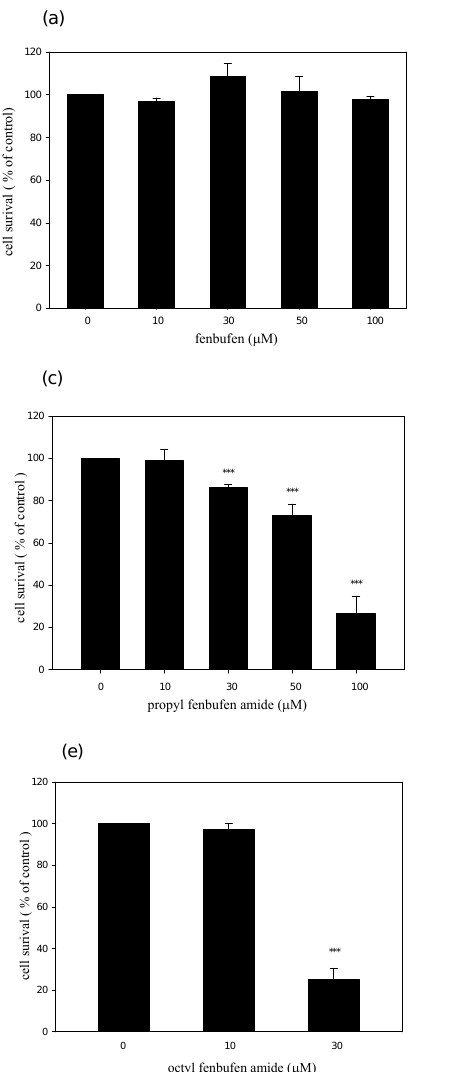
Figure 2. Effects of fenbufen and its amide analogs on cell viabilities in RAW 264.7 cells. Cell viability was estimated using mitochondria MTT assay: (a) fenbufen; (b) methyl fenbufen amide; (c) propyl fenbufen amide; (d) butyl fenbufen amide; (e) octyl fenbufen amide. *** p < 0.001 indicate statistically significant